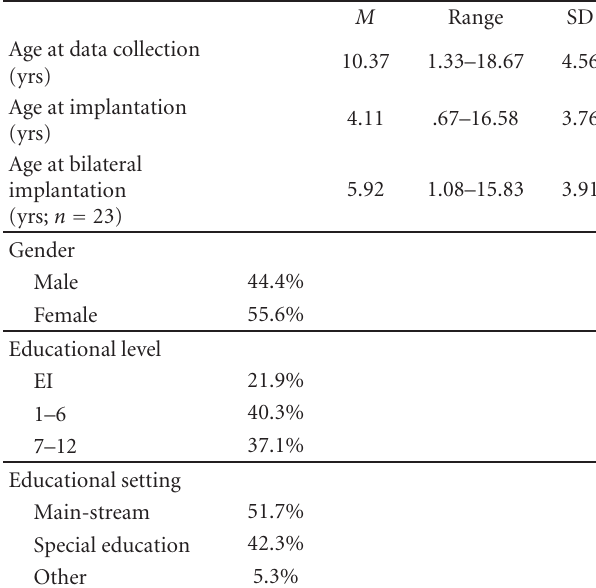
Table 2: Characteristics of children in the teacher surveys ( N =